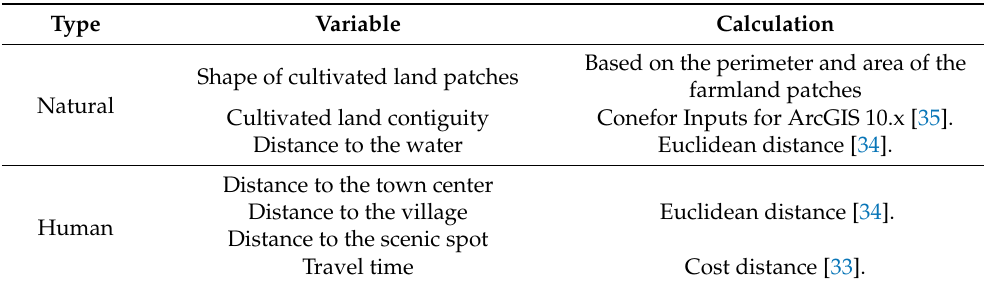
Table 7. Description of the variables utilized for mapping the spatial distribution of the farmland recreational function. Type Variable Calculation Based on the perimeter and area of the Shape of cultivated land patches farmland patches Natural Cultivated land contiguity Conefor Inputs for ArcGIS 10.x [35]. Distance to the water Euclidean distance [34]. Distance to the town center Euclidean distance [34].Distance to the village Human Distance to the scenic spot Travel time Cost distance